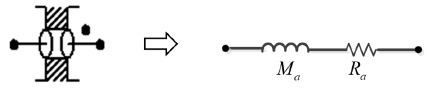
Figure 6. Hole model and its equivalent circuit.